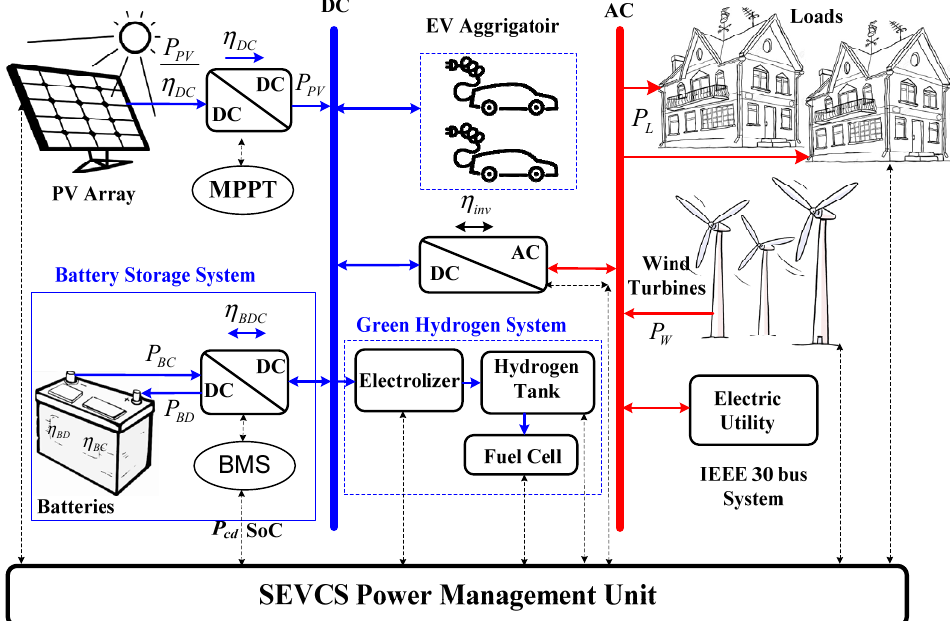
Figure 1. Smart EV charging station (SEVCS).